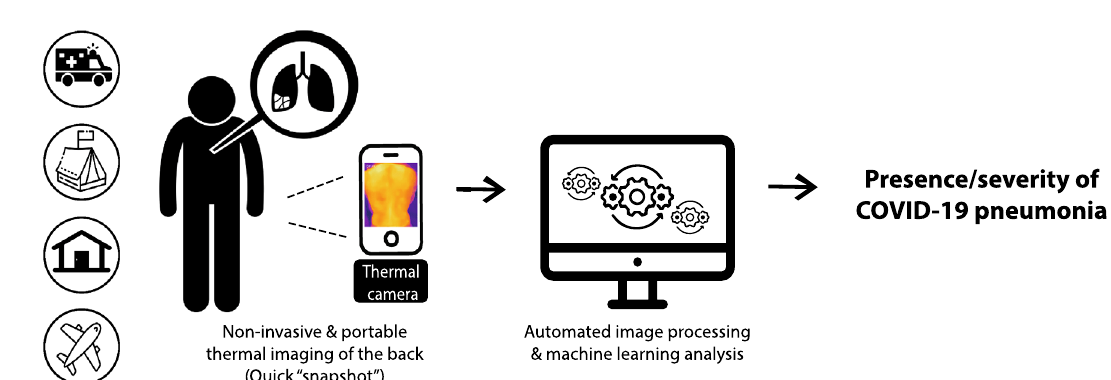
Figure 6. Graphical abstract. A schematic illustration of the research design and potential